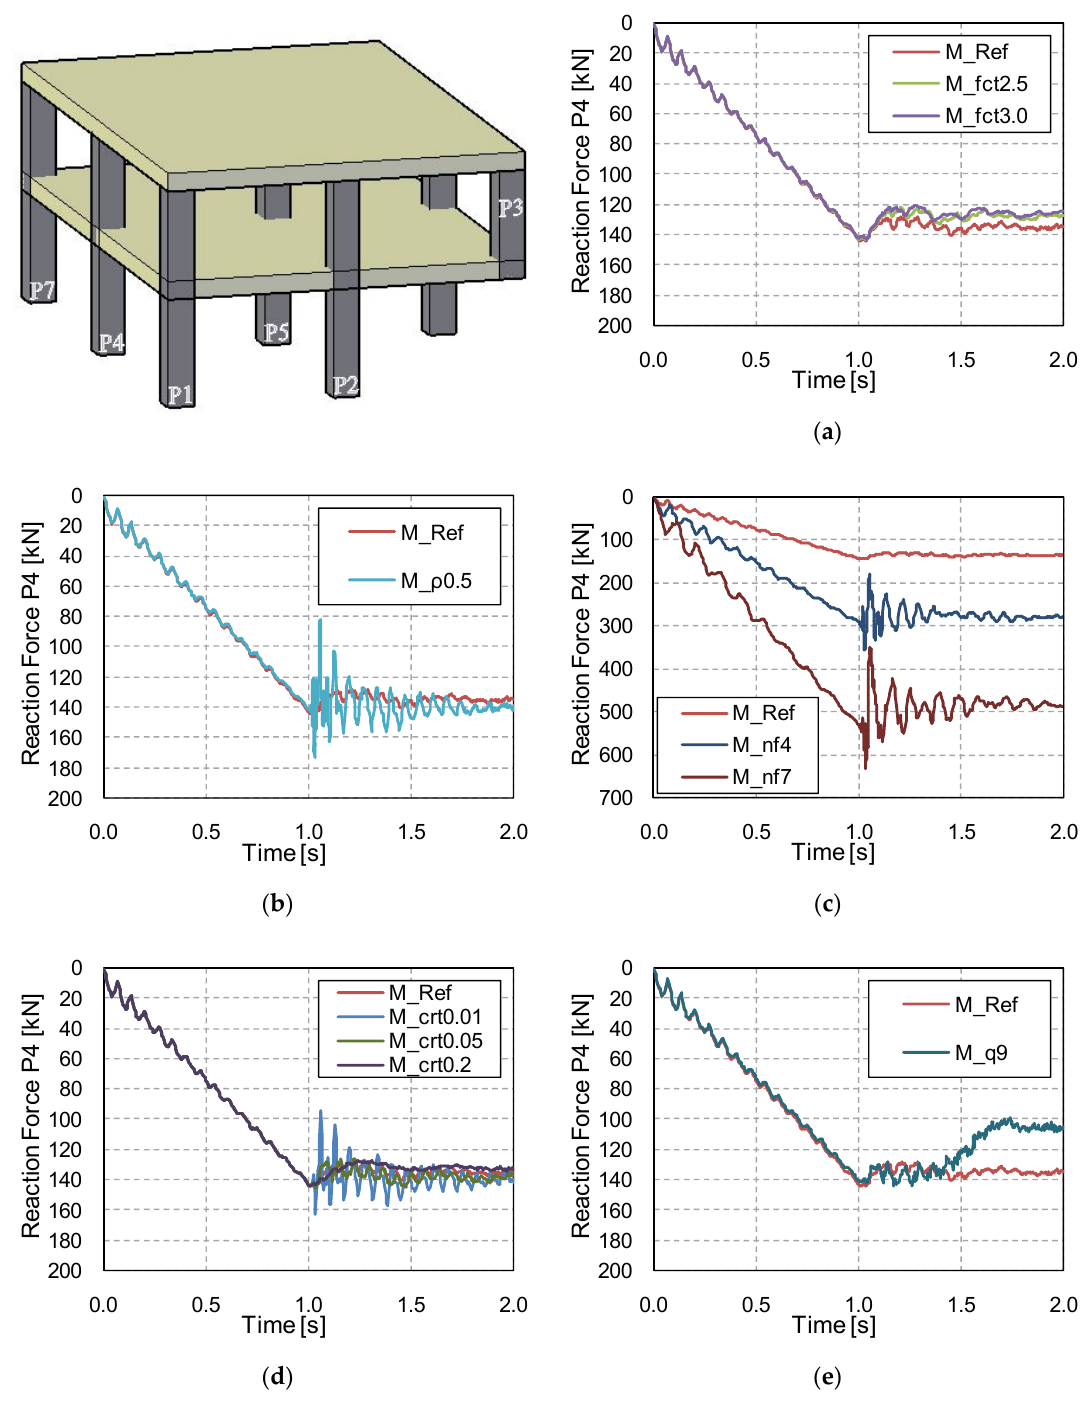
Figure A2. Numerical reaction in P4 obtained by varying ( a ) concrete tensile strength, ( b ) flexural reinforcement ratio, ( c ) number of floors, ( d ) column removal time and ( e ) superimposed load. Positive values indicate compression.